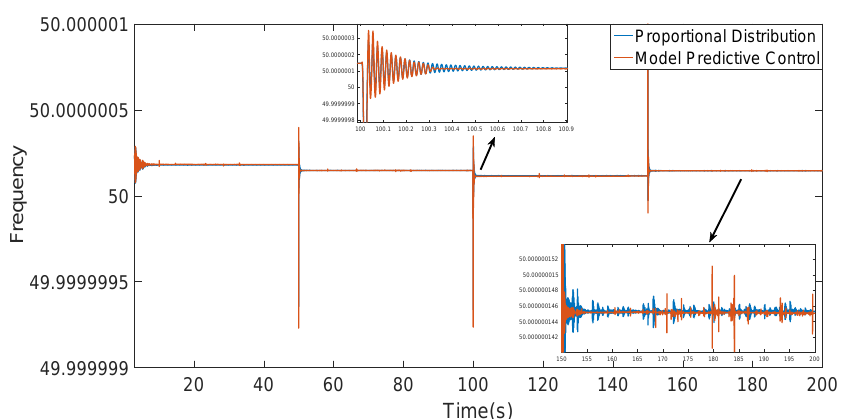
Figure 17. Wind farm exit node frequency response (20 units under model predictive